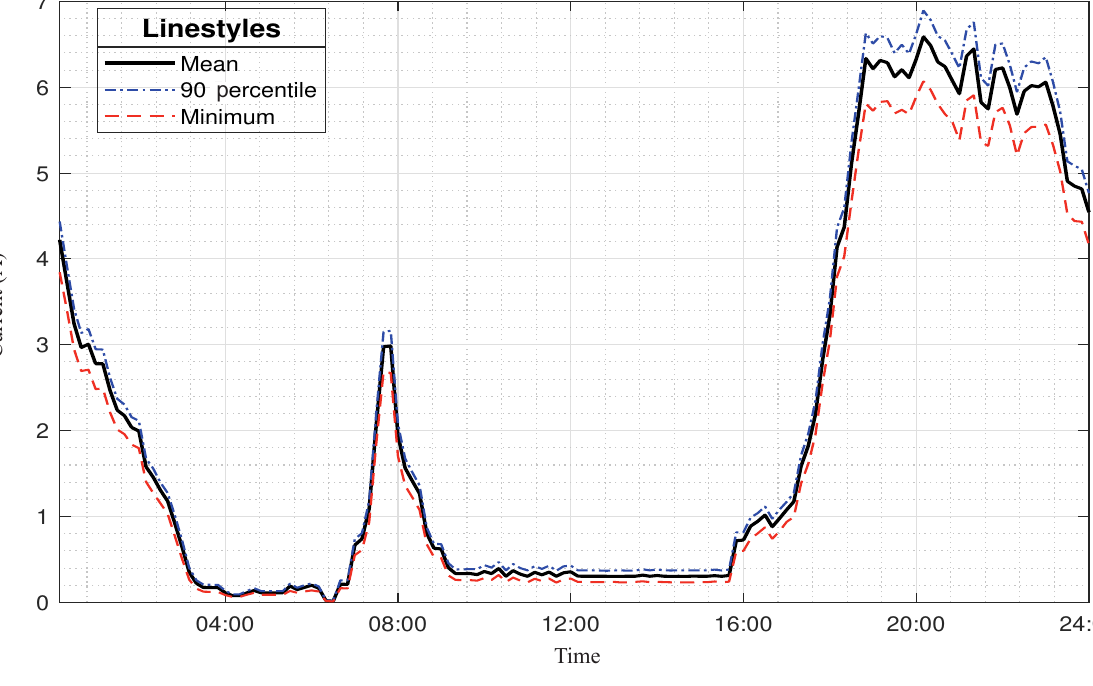
Fig. 10. Total RMS current estimated for the lighting load of 60 houses for 100